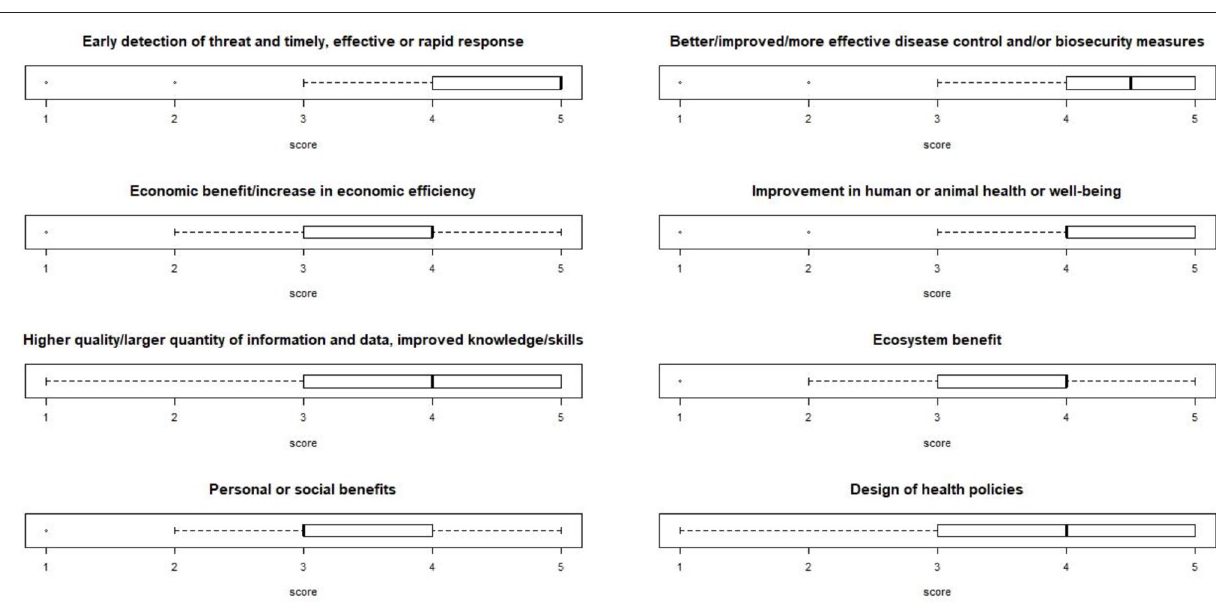
FIGURE 4 | Boxplot of the scoring of the OH advantages, described in literature. Respondents could score each from one (low) to five